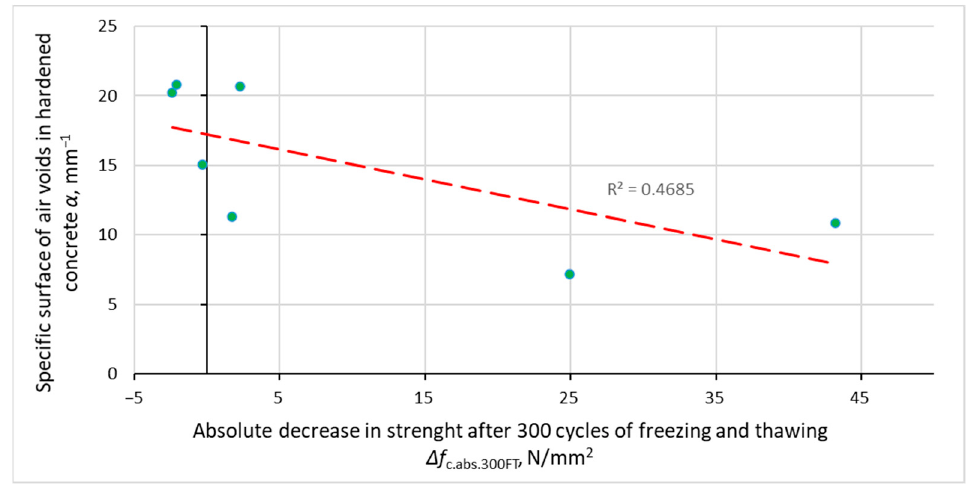
Figure 11. Dependence between specific surface air voids in hardened concrete and reduction in concrete compressive strength after 300 cycles of freezing and thawing.